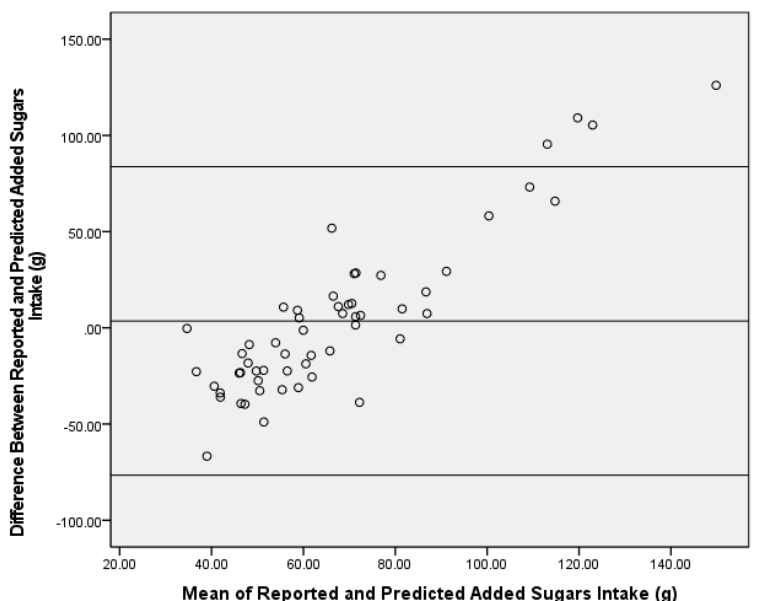
Figure 2. Bland–Altman analysis of reported and predicted added sugars intake (g) using a δ 13 C single-carbon stable isotope ratio prediction model in the test group ( n = 56) . * The center line rep- resents the mean difference, and the upper and lower lines indicate the mean ± 1.96 standard devi- ation.